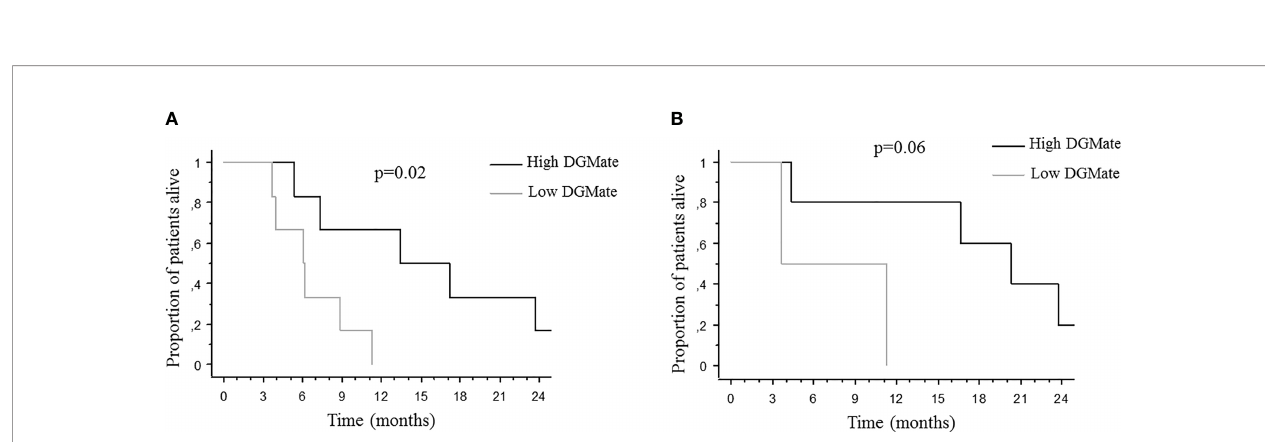
FIGURE 5 | Median overall survival after brain metastases diagnosis according to DGMate score in BM among patients with rectal tumor (A) and patients with multiple BMs (B) . Kaplan-Meier method was used to determine OS. DGMate score was split at median and p value calculated using the Logrank